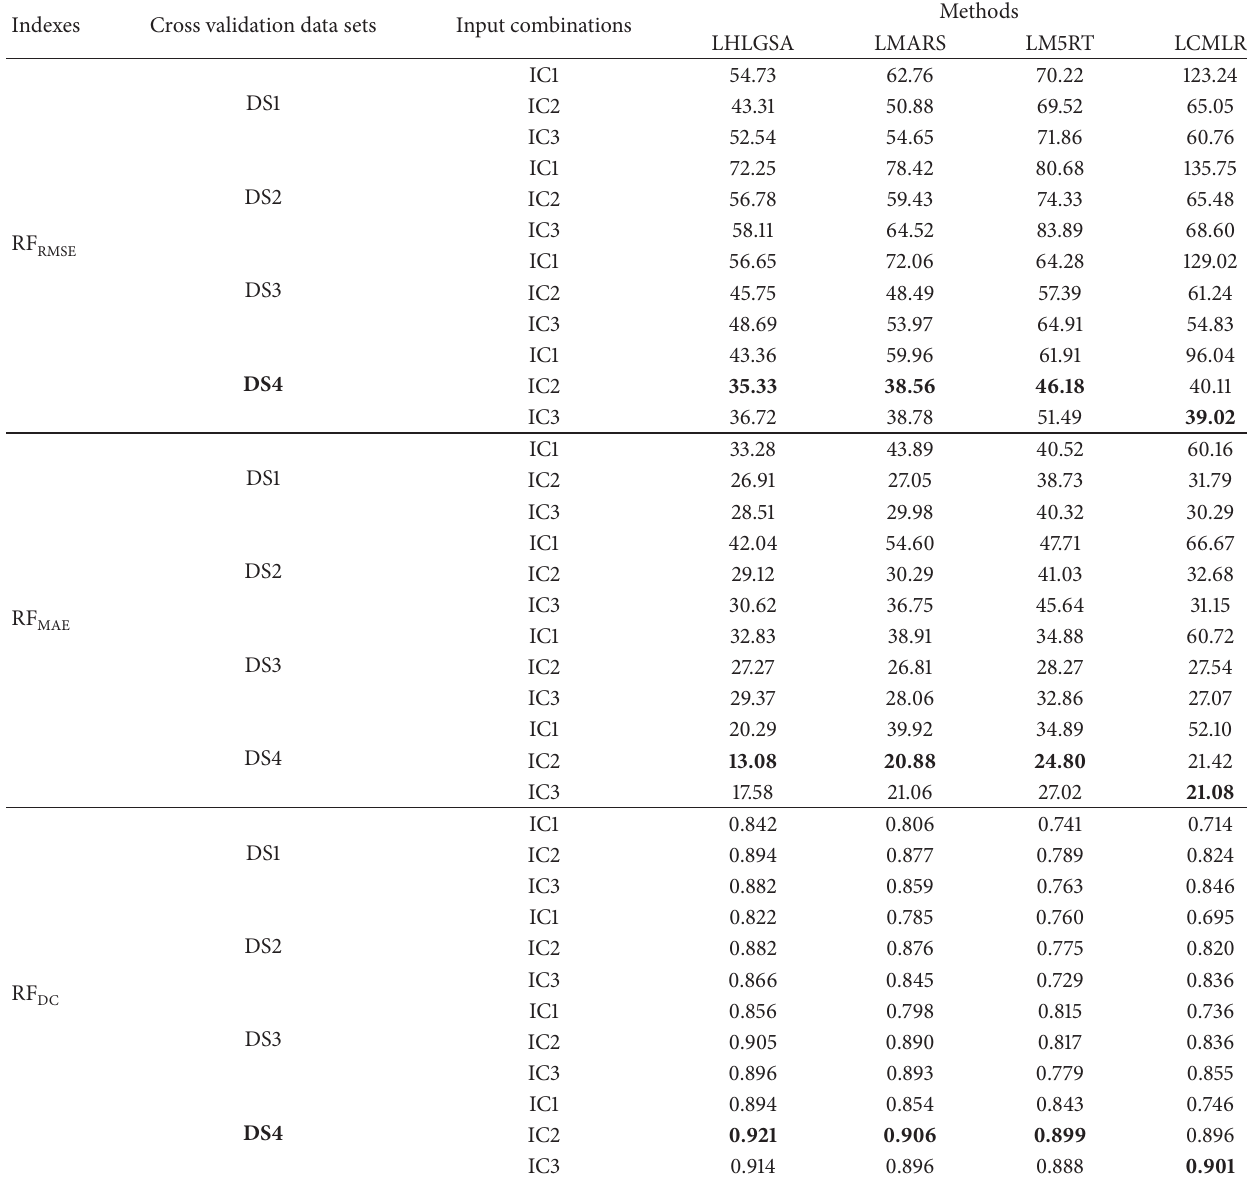
Table 5: Comparison of the LHLGSA, LMARS, LM5RT, and LCMLR methods: Astore